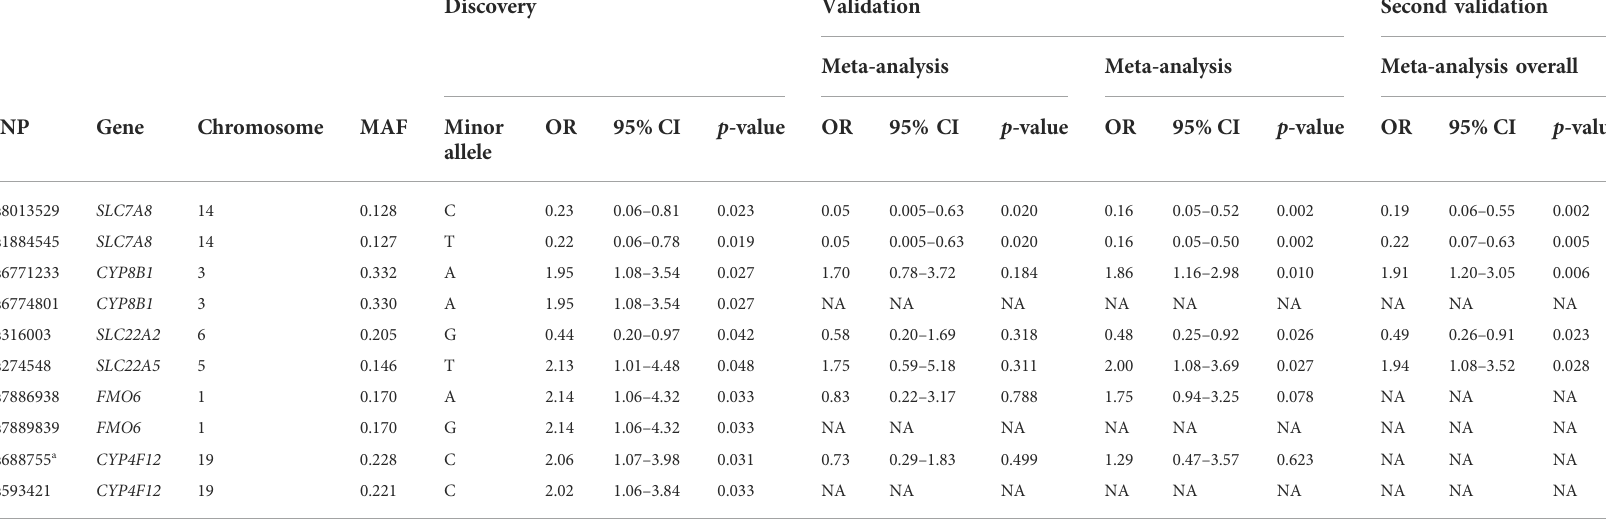
TABLE 2 Results of the association analysis in the discovery and validation cohorts. In the discovery cohort, 710 genetic variants in drug metabolizing enzymes and transporters were assessed for their association with early disease progression (EDP) in patients with osteosarcoma. Variants with a signi fi cant association were manually genotyped and analyzed in the validation cohorts. The results were combined in